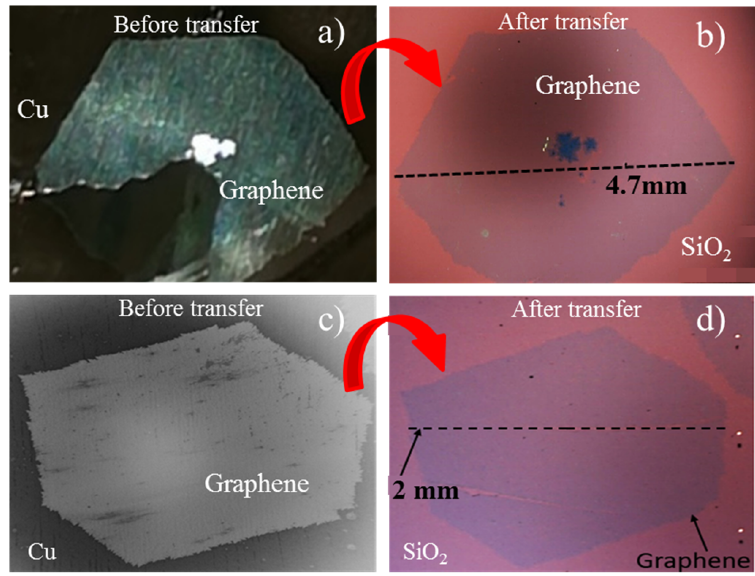
Figure 3. Optical ( a , b , d ) and SEM ( c ) images of single crystal graphene before and after transfer to SiO 2 substrate. ( a , b ) The sample without any annealing. ( c , d ) The sample with post-growth anneal- ing.